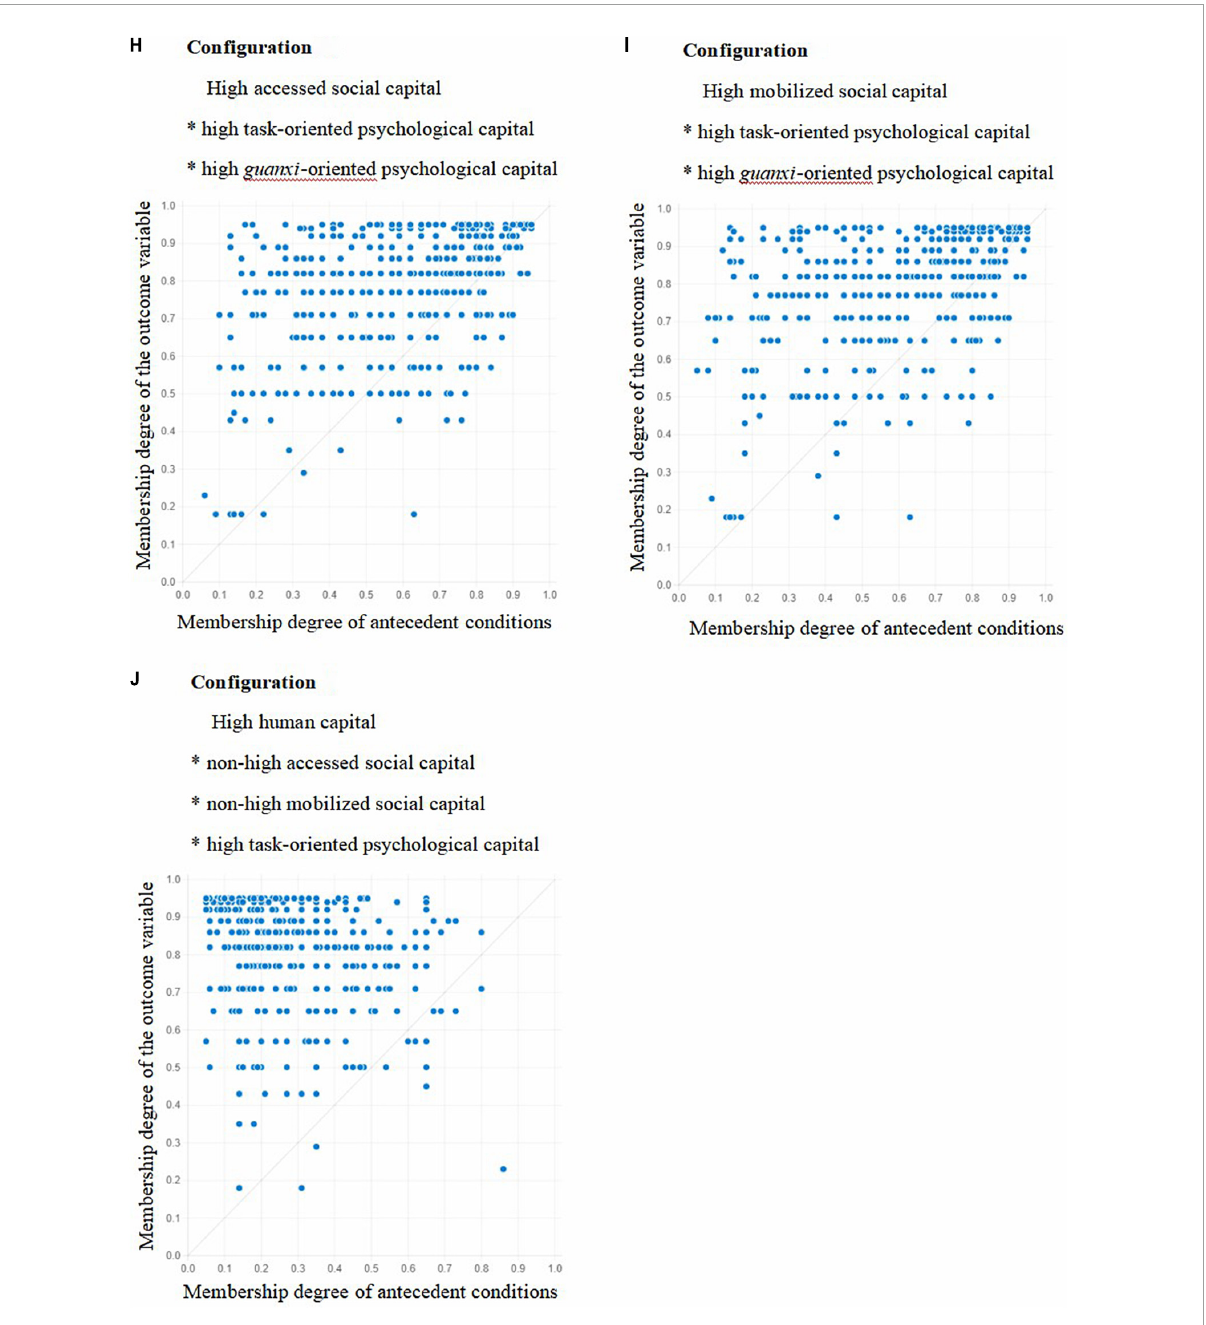
FIGURE3 Fuzzy subset relation diagrams for Configurations H–J , and task performance * contextual